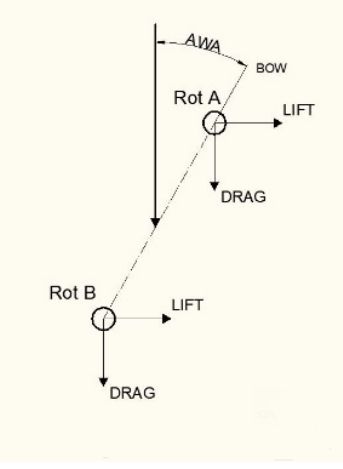
Figure 6. Arrangement of the rotors. Table 1. Rotors working parameters.